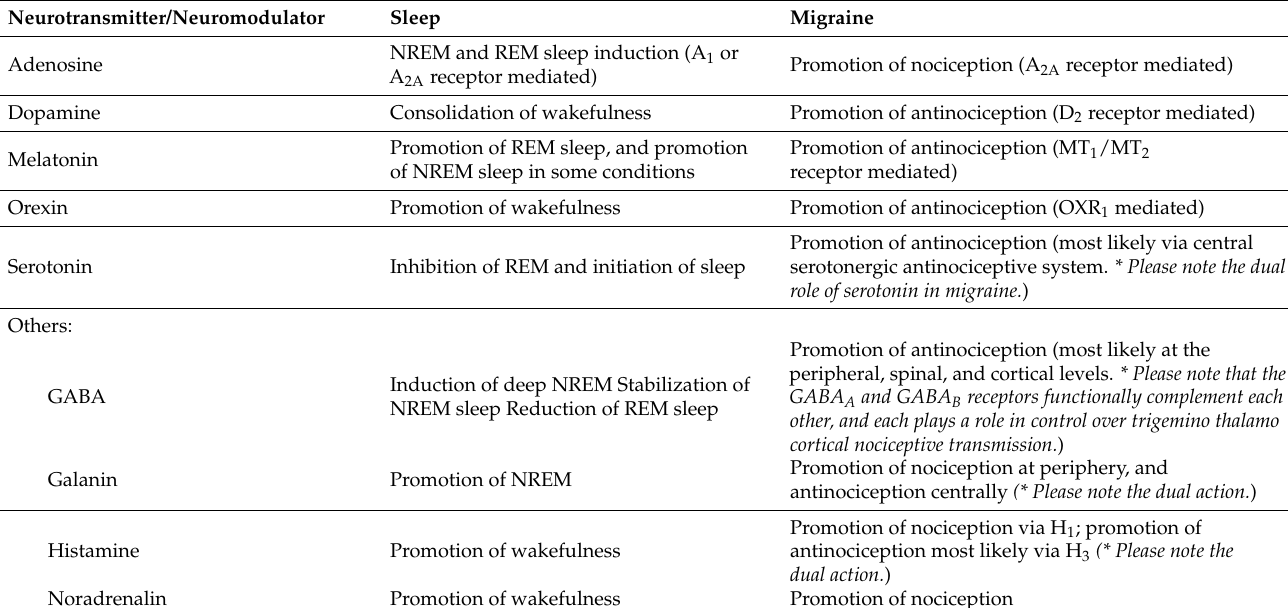
Table 1. Proposed common neurotransmitters/neuromodulators in sleep and migraine (based on the literature [5,13,14,22,55,56]).